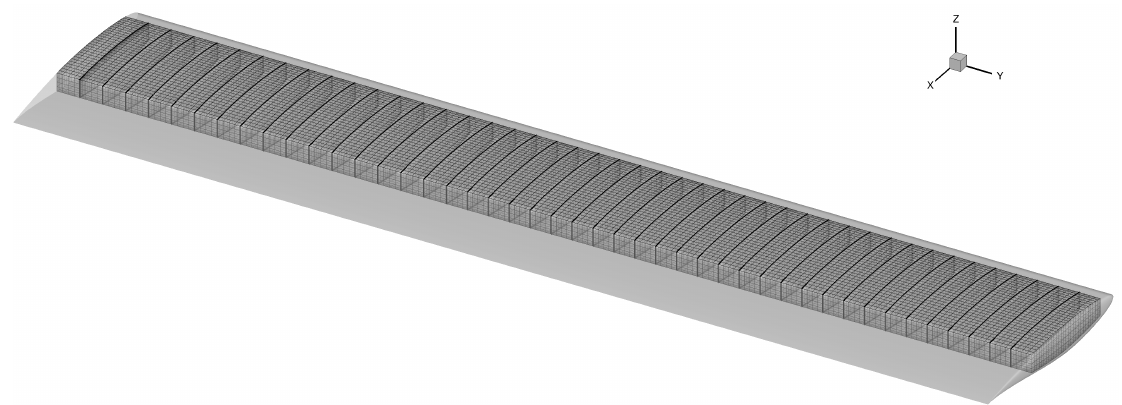
Figure 4. The FEA mesh has 16,672 2nd-order shell elements.